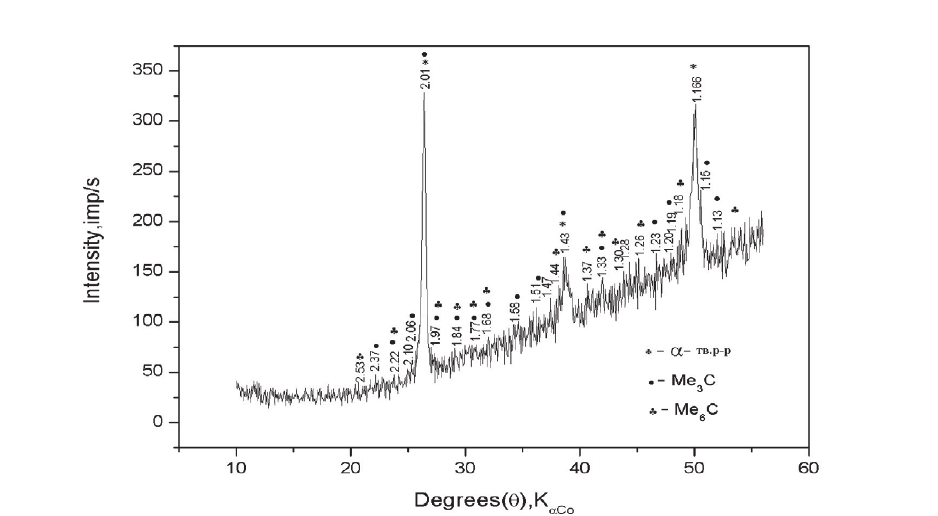
Figure 6: XRD patterns of HS 6-5-2 steel surface before electrical discharge modification in electrolyte